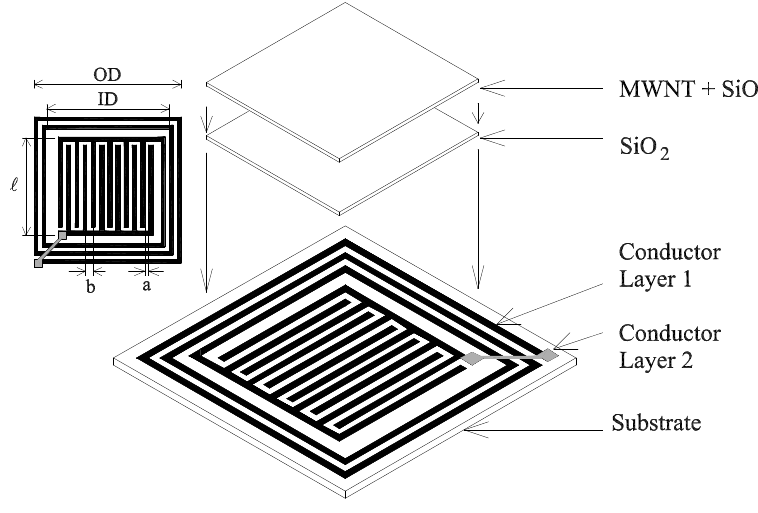
Figure 1. The schematic drawing of the CO